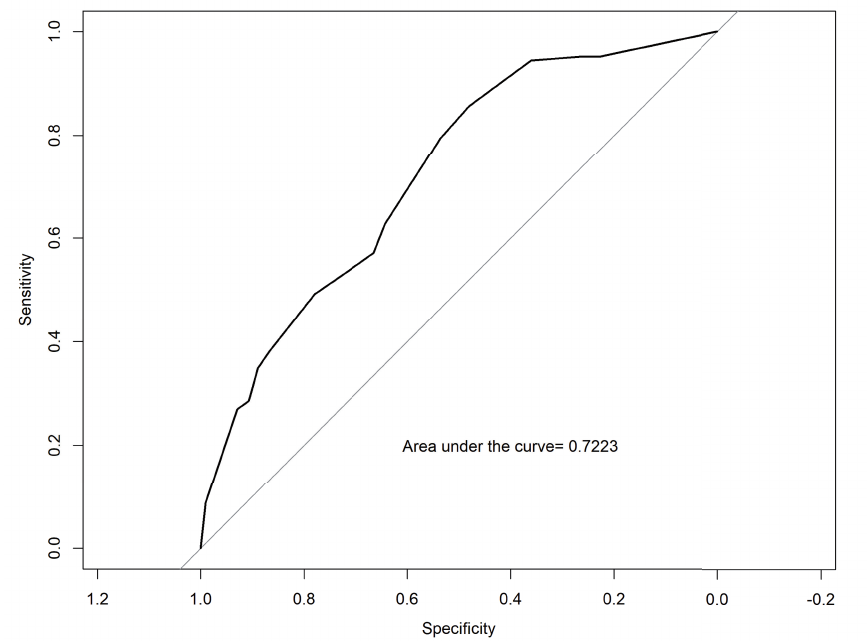
Figure 3 - Receiver-Operator Characteristics Curve of the Moreira Tables Predicting Bone Scan